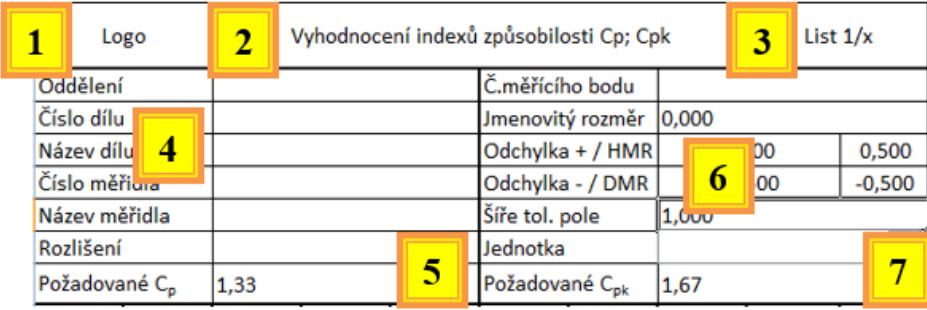
Figure 2: Identification field of the evaluation tool